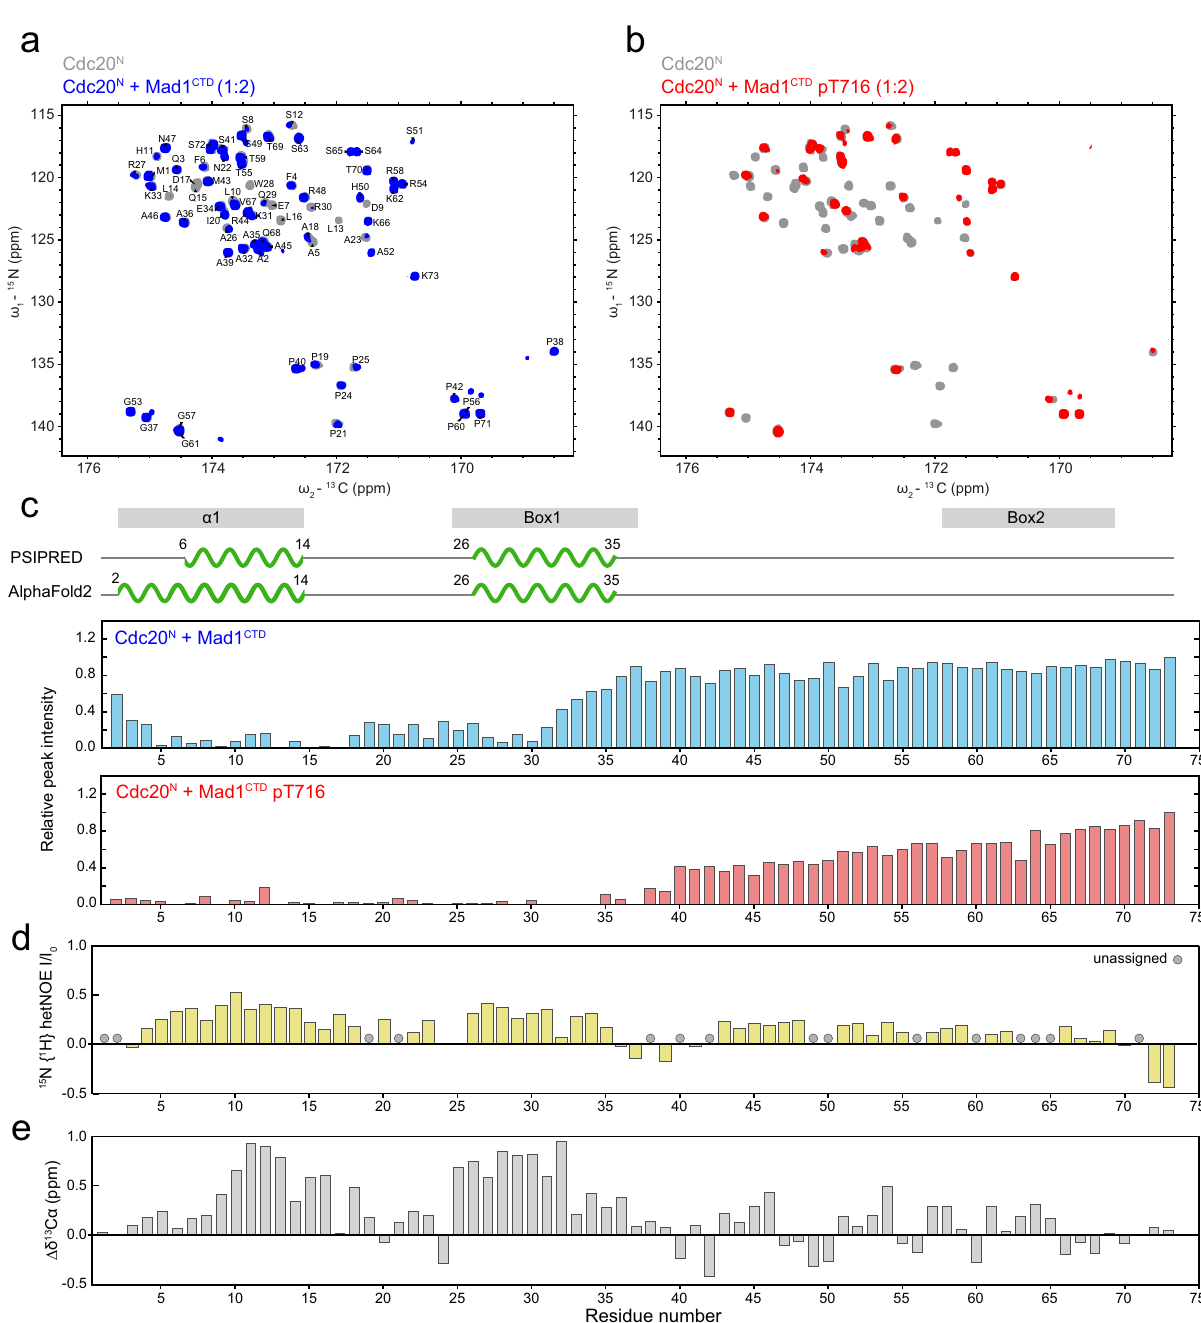
Fig. 3 | Characterisation of Cdc20 N and its interaction with Mad1 CTD . a 13 C-detected 2D CON spectra of Cdc20 N alone (grey) and in the presence of Mad1 CTD (blue) at a four molar excess, shown with the assignment of Cdc20 N backboneresonances. b 13 C-detected2DCONspectraofCdc20 N alone(grey)andin the presence of Mad1 CTD pT716 (red) at a twofold molar excess. c Relative peak intensities from the CON spectra of Cdc20 N in the presence of Mad1 CTD (blue) and Mad1 CTD pT716(red)weremappedontotheCdc20 N sequence.Peakintensitieswere normalised to the C-terminal residue Gly73. Regions showing signi fi cant line